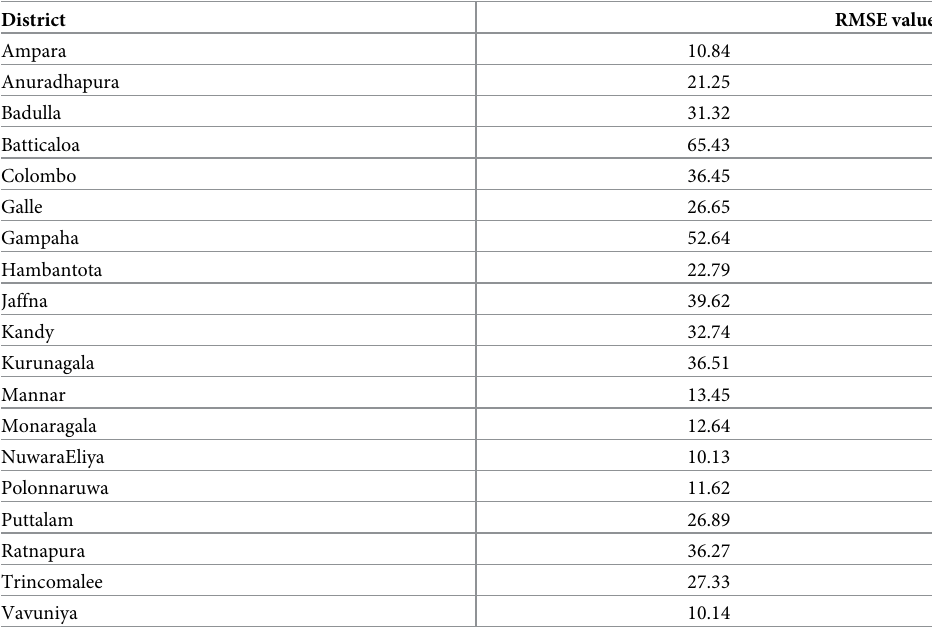
Table 2. The RMSE values of each districts. District RMSE value Ampara